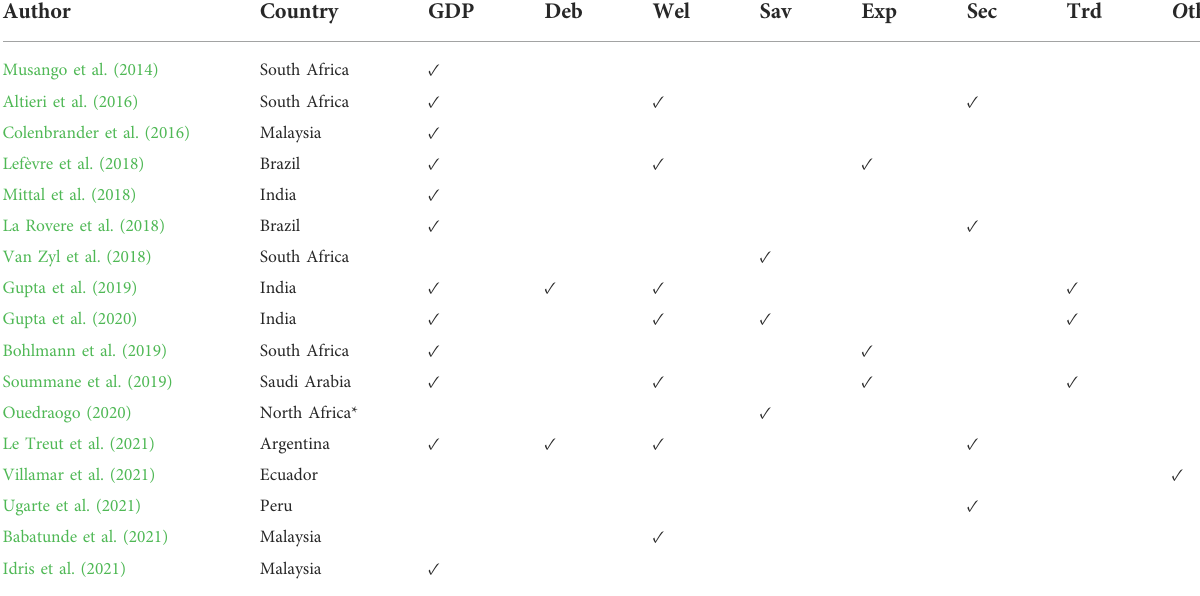
TABLE 5 Share of studies analyzed selected major macroeconomic indicators (besides investment cost and